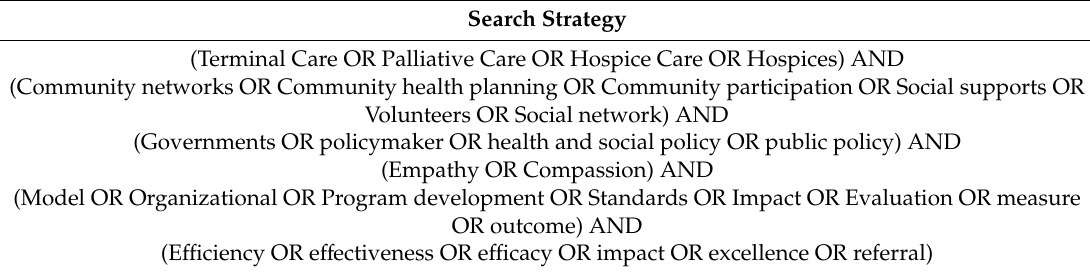
Table 1. Search strategy.